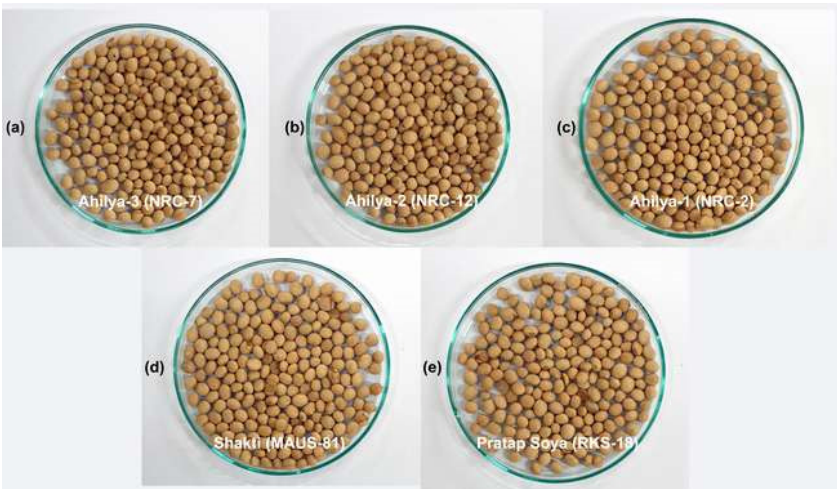
Fig. 1: Wheat varieties collected from the local farms in Rewa district, Madhya Pradesh, India. (a) LOK-803. (b) HI-1544. (c) LOK-273